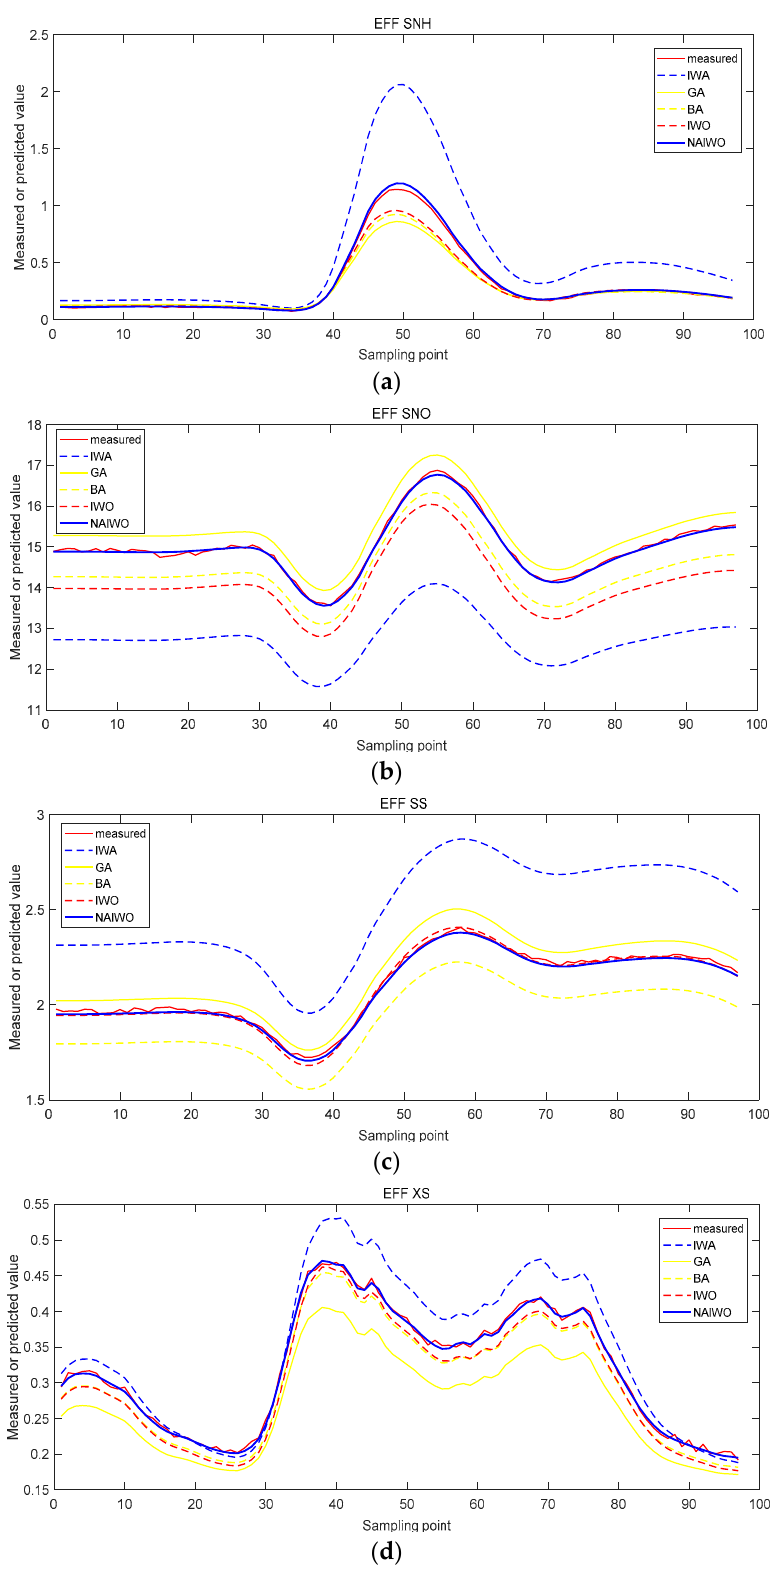
Figure 6. Comparison of predicted and measured values of effluent water quality parameters for ( a ) Ammonia nitrogen ( S NH ), ( b ) nitrate nitrogen ( S NO ), ( c ) soluble rapidly biodegradable organic matter ( S S ), and ( d ) insoluble slowly degradable organic matter ( X S ) in WC-WWTP. Figures 5a–d and 6a–d are the effluent S NH , S NO , S S , and X S concentration curves of PC-WWTP and WC-WWTP. The red solid line in the figure represents the actual measured water quality